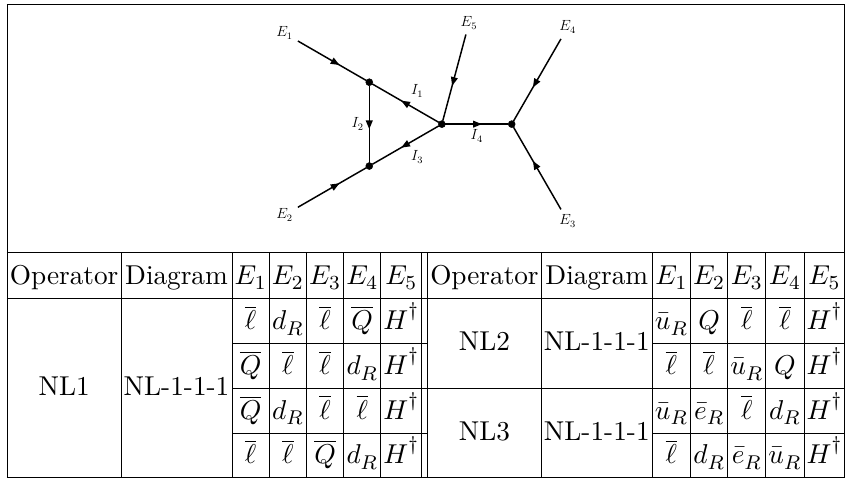
Table 2 . The possible external field attachments for the topology NL-1-1, where the external and internal fields are labelled as E